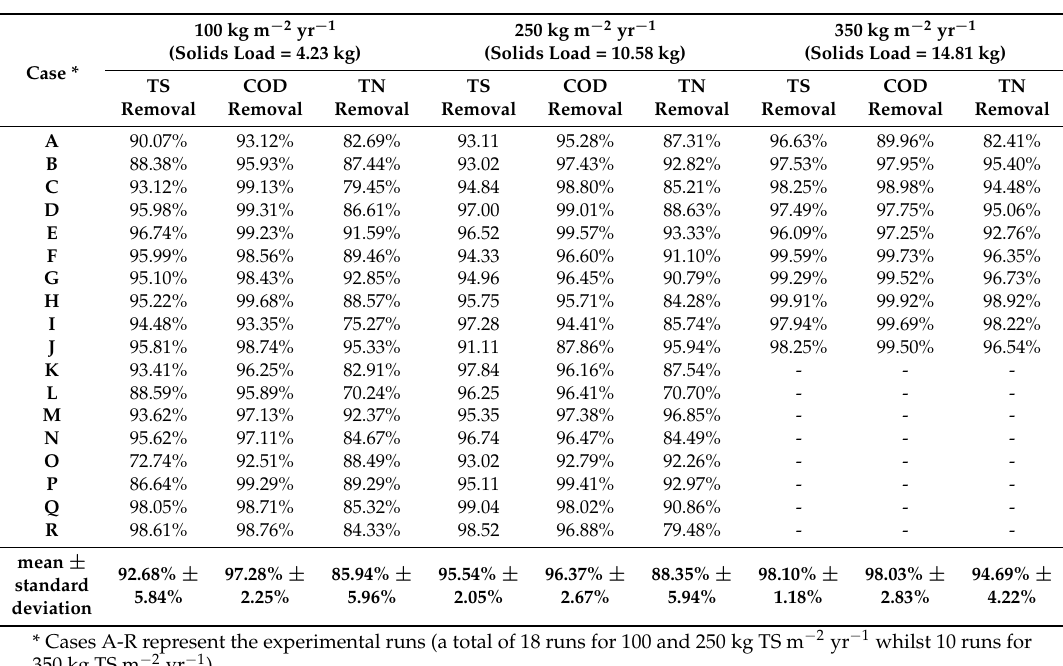
Table 4. Treatment performance in Phase I of the